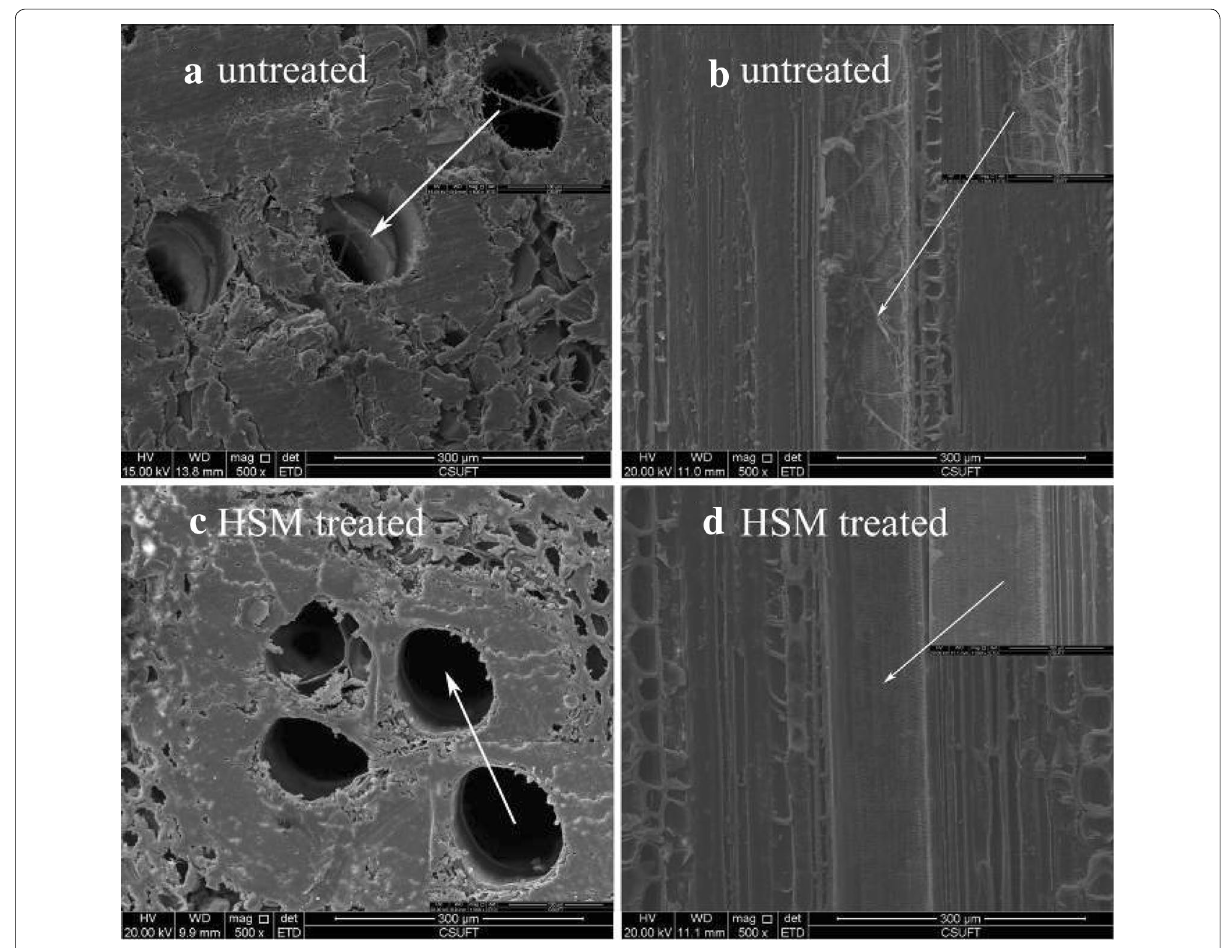
Fig. 9 SEM image of untreated and HSM-treated bamboo after molds test. a Cross section of untreated bamboo; b longitudinal section of untreated bamboo; c cross section of HSM-treated bamboo; and d longitudinal section of HSM-treated bamboo